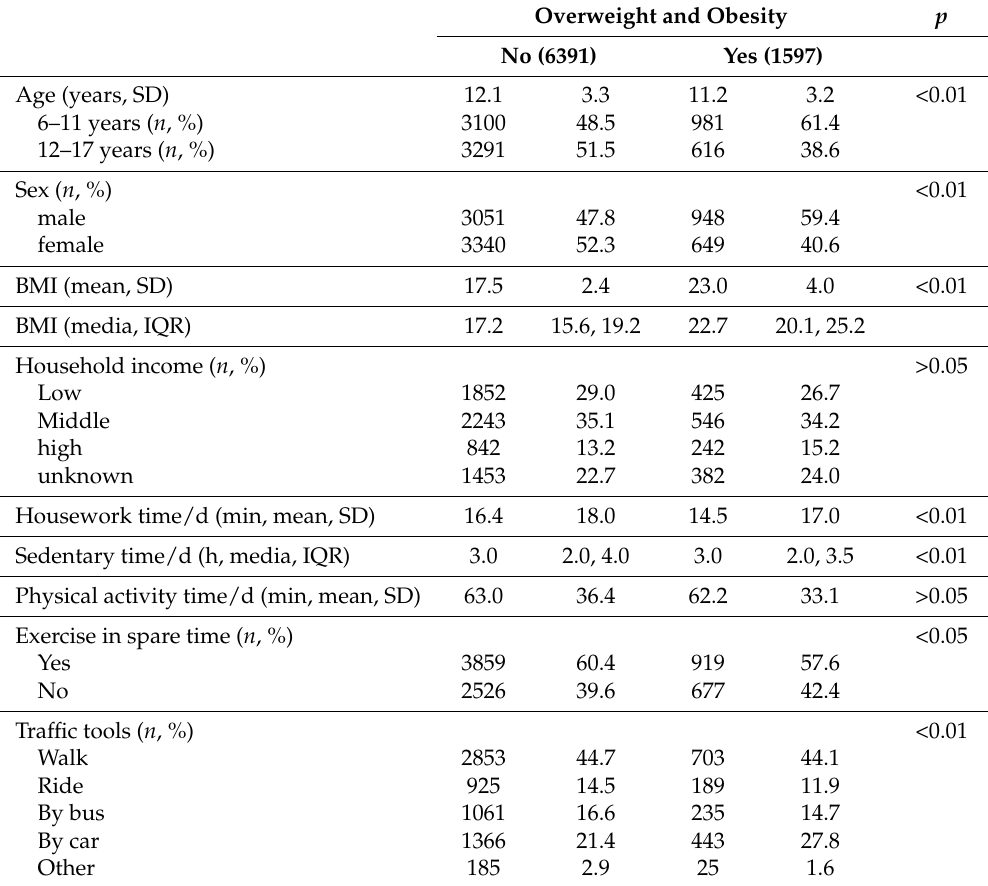
Table 1. General characteristics of study participants ( n =